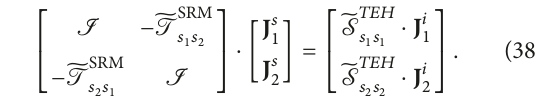
Figure 5: Each object is enclosed by an equivalence